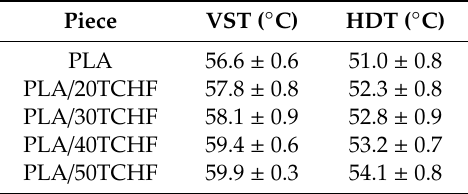
Table 5. Thermomechanical properties of the injection-molded pieces of polylactide (PLA) with torrefied